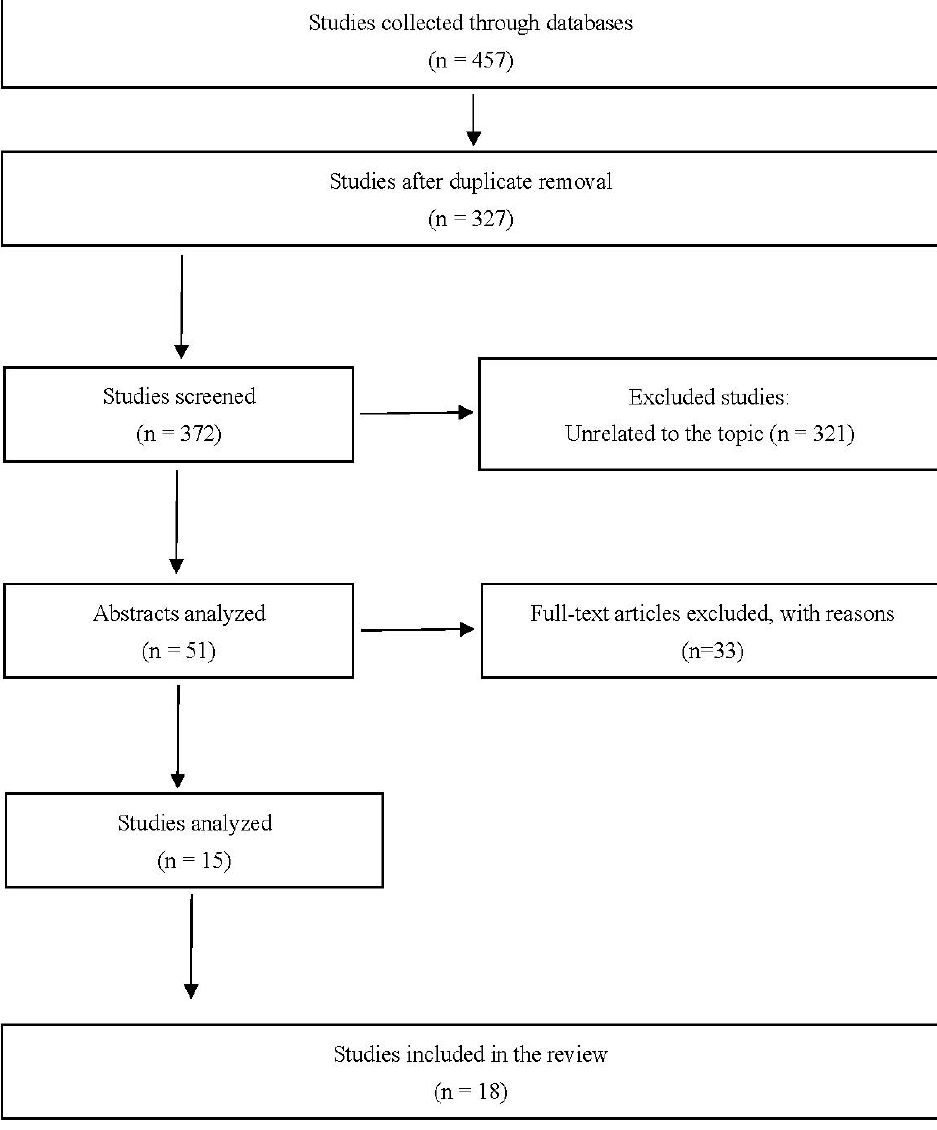
Figure 1. Flowchart of selection of studies. Note: PRISMA figure adapted from Moher, Liberati, Tetzlaff, Altman, The PRISMA Group (Moher et al. 2009); Creative